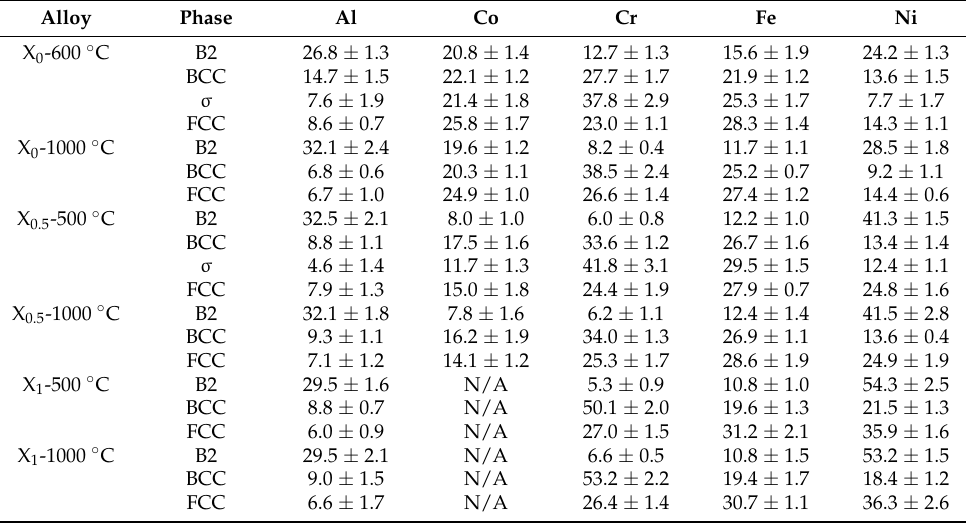
Figure 16. SEM-BSE images of the three aged alloys: ( a , b ) X 0 at 600 and 1000 ◦ C; ( c , d ) X 0.5 at 500 and 1000 ◦ C; and ( e , f ) X 1 at 500 and 1000 ◦ C. Table 9. Chemical composition (wt.%) of the interior structures marked in Figure